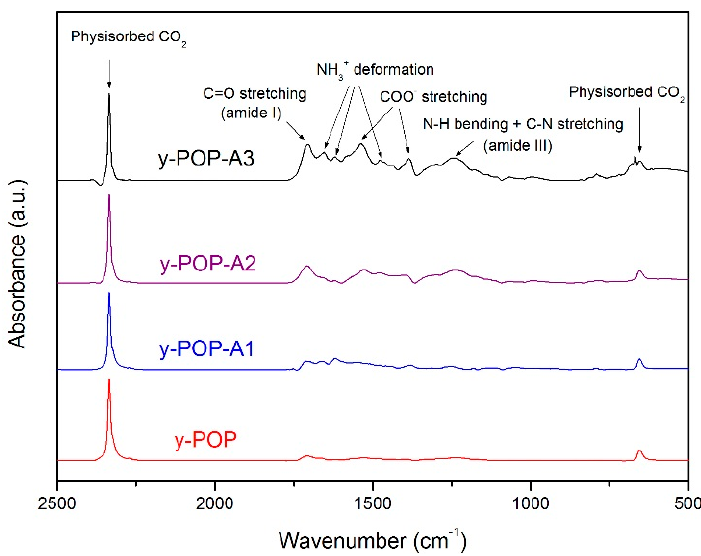
Figure 2. Infrared (IR) spectra of adsorbed CO 2 on ynone-linked porous organic polymer (y-POP) and y-POP-NH 2 .